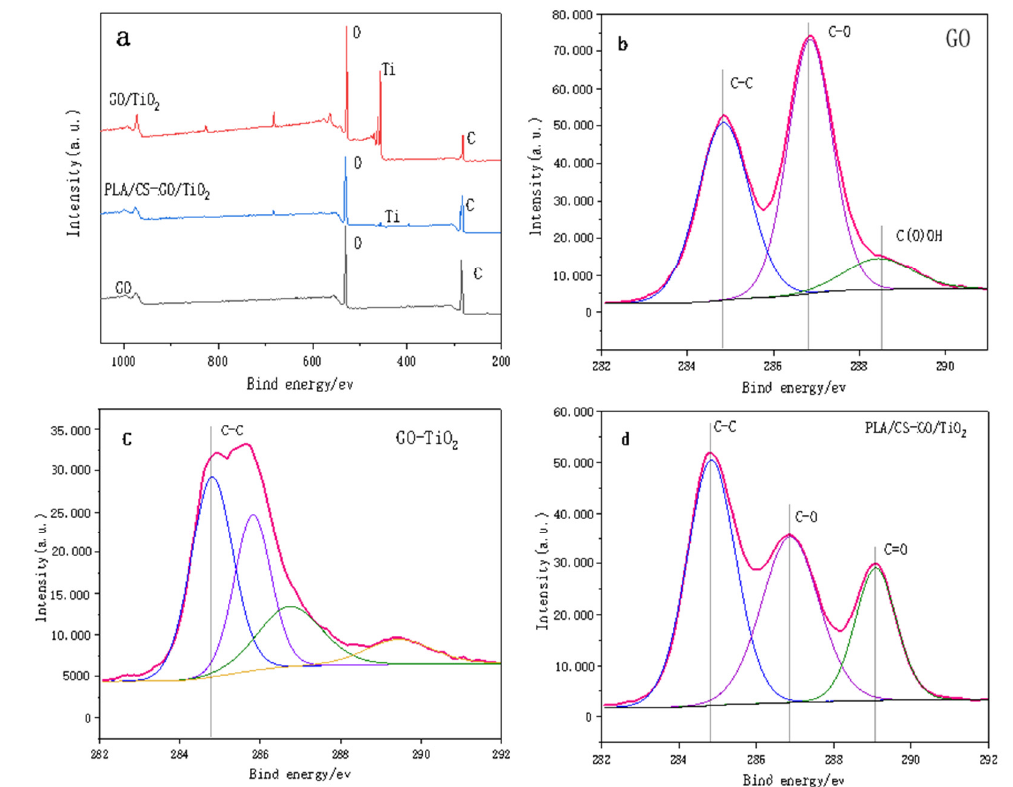
Figure 5. ( a ) Survey XPS spectra of GO, GO and PLLA/CS–GO/TiO 2 . High-resolution C 1s XPS spectra of ( b ) GO, ( c ) GO/TiO 2 and ( d ) PLLA/CS–GO/TiO 2 .